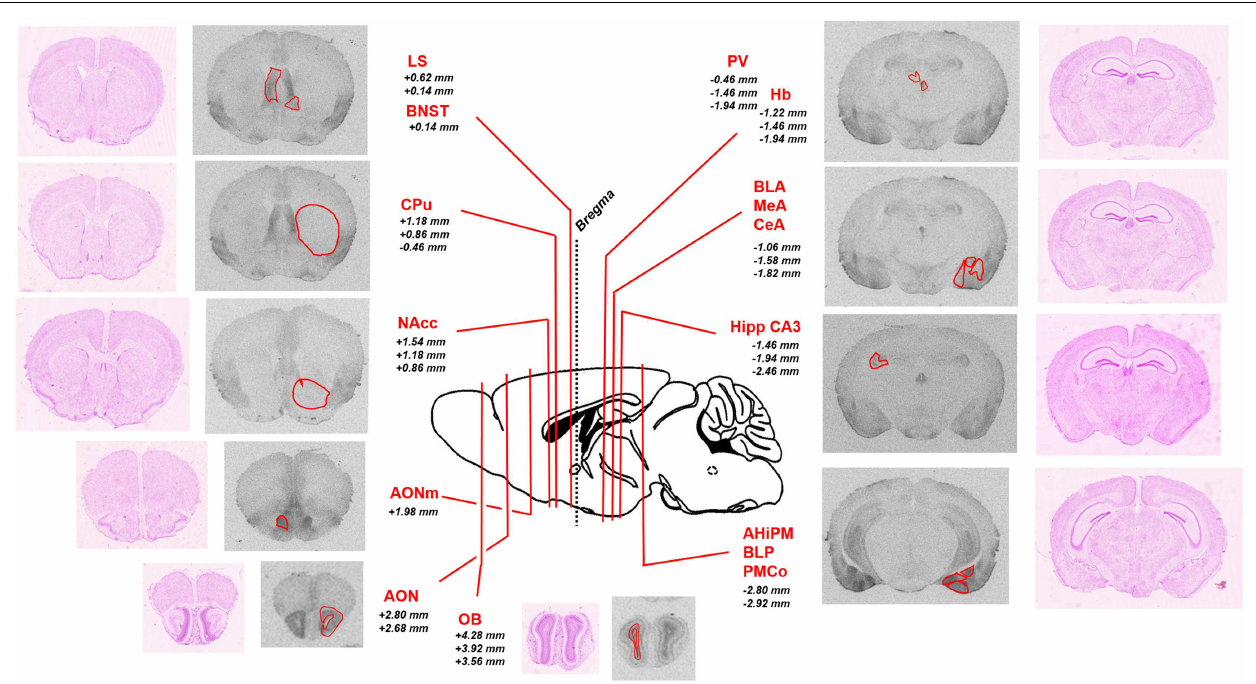
FIGURE 1 | Schematic representation of the brain regions of interest analyzed in the study . Representative sections of autoradiographic labeling of OXTR with [ 125 I]-OVTA 20pM are displayed in grayscale, flanked by corresponding Nissl stained sections. Red contours outline the regions of interest analyzed. A sagittal schematic representation of a mouse brain is reported in the central panel. Lines indicate the antero-posterior localization of the coronal sections taken into account, defined by the reported distances (millimeter) from bregma (according to the Franklin and Paxinos (41)